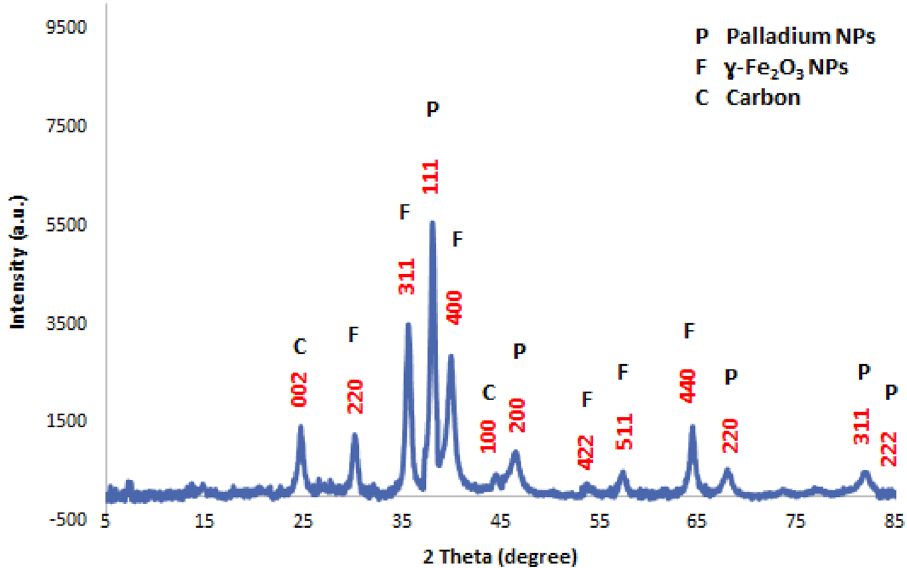
Figure 2. XRD pattern of Pd@h-Fe 2 O 3